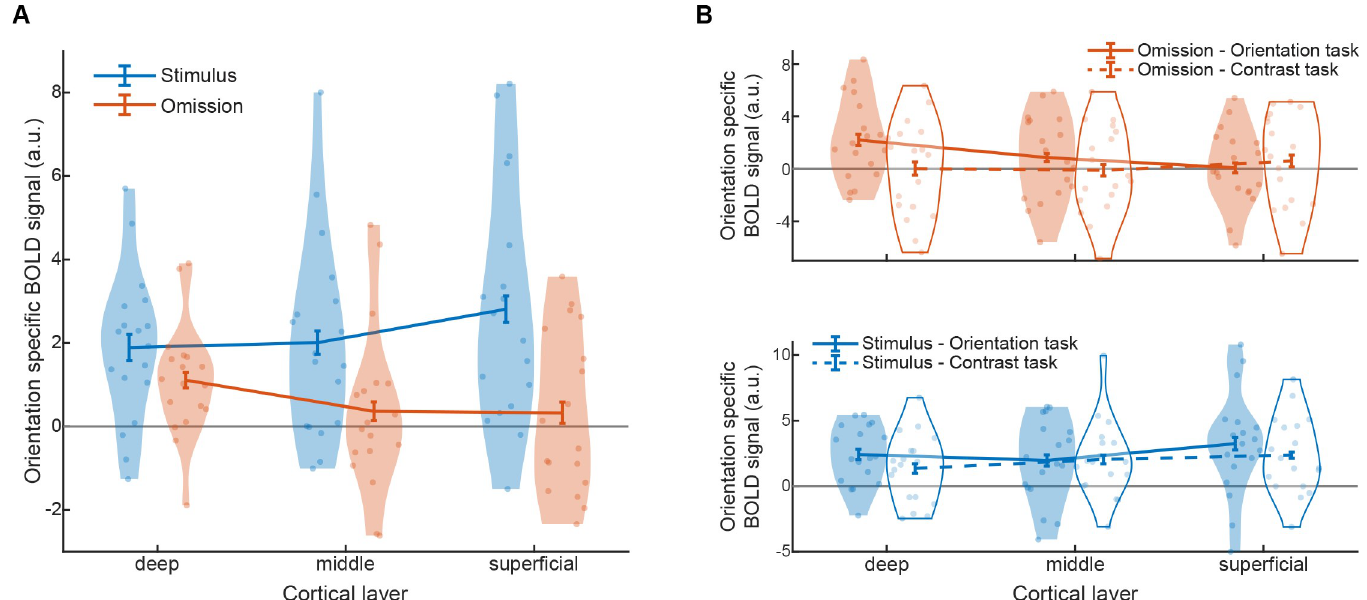
Fig 3. Layer-specific BOLD response in V1 for presented and expected stimuli. (A) Orientation-specific BOLD response to presented (blue) and expected-but-omitted (orange) gratings in the different layers of V1, averaged over tasks. (B) Orientation-specific BOLD response to expected-but-omitted (orange, top panel) and presented (blue, bottom panel) gratings, separately for the orientation (solid lines, filled shapes) and contrast (dashed lines, open shapes) tasks. Dots represent individual participants, and curved shapes indicate density. Error bars indicate within-subject SEM. Data are available at osf.io/k54p3. BOLD, blood oxygen level–dependent; SEM, standard error of the mean; V1, primary visual